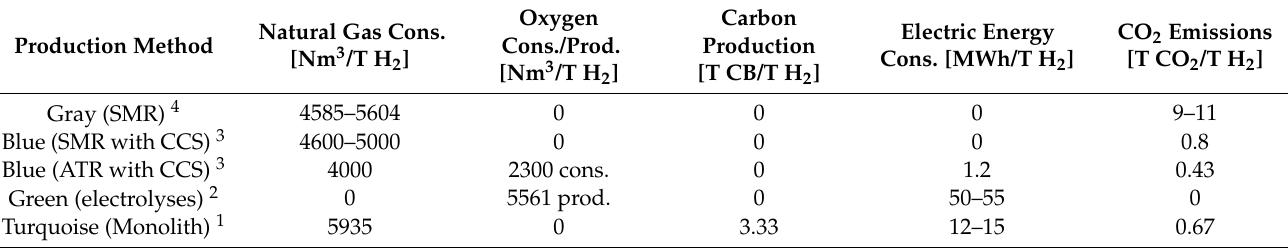
Table 1. Natural gas consumption, oxygen consumption/production, carbon black production, electric energy consumption and CO 2 emissions per ton hydrogen for different production methods.